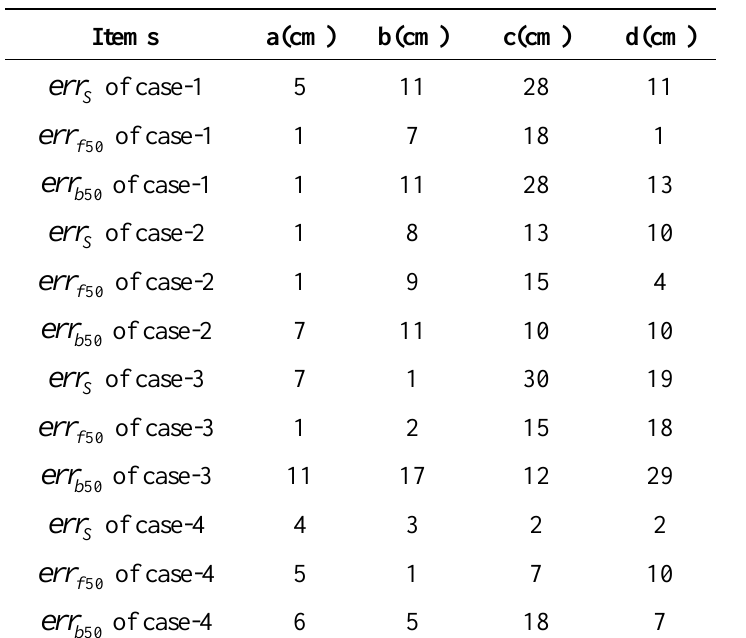
Table 6. The errors of the detection results corresponding to the cases